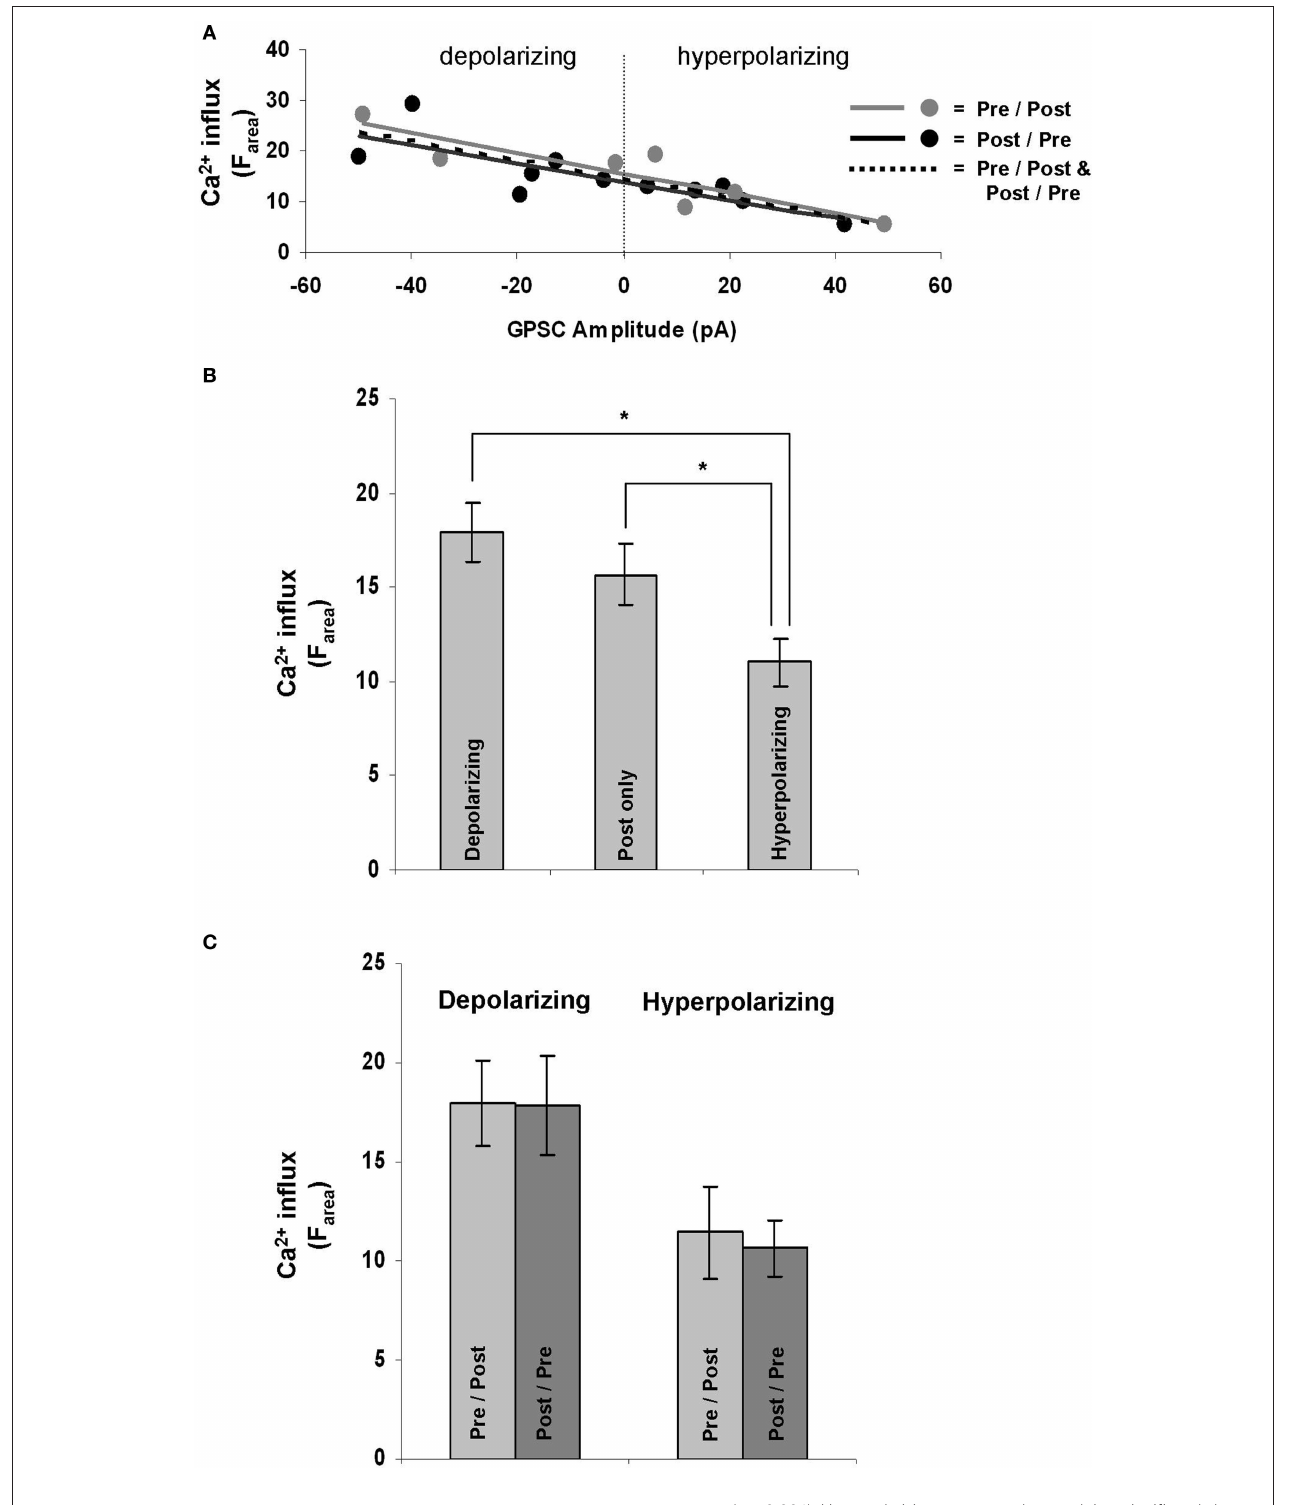
synapses ( p = 0.004). Hyperpolarizing synapses also result in a significantly lower Ca 2 + influx than the firing of a neuron alone (post only; p = 0.045). (C) There was no significant difference in Ca 2 + influx when STDP was induced in post/pre or pre/ post orders at depolarizing ( p = 0.96) and hyperpolarizing